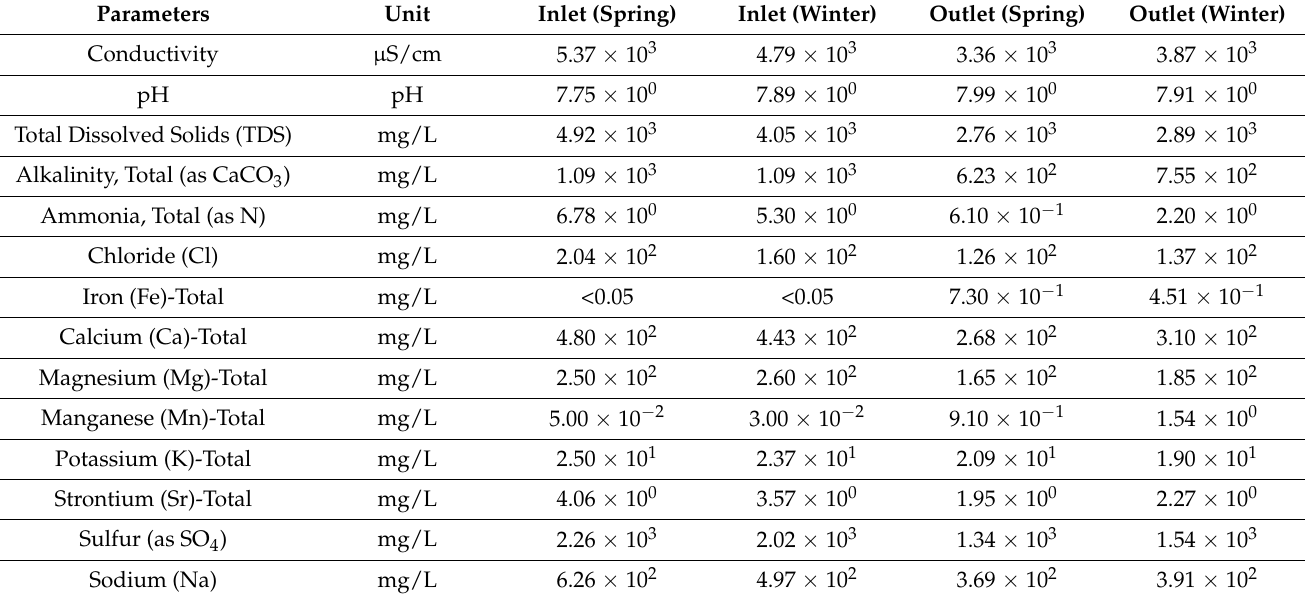
Table 3. General chemistry analysis WTP wastewater entering and leaving the ponds as sampled in spring (May) and winter (December). Samples were collected within an hour of each